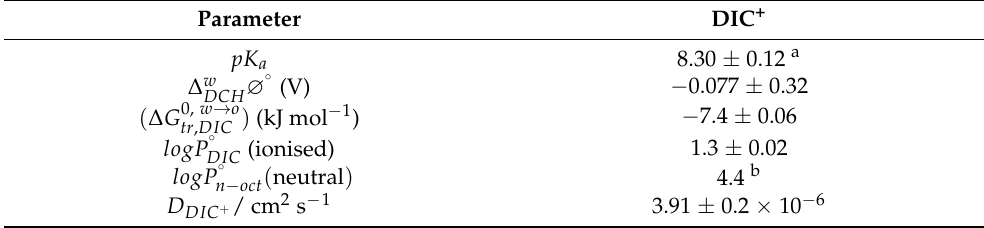
Table 1. The formal transfer potential, the standard Gibbs energy of transfer and the partition coefficient of ionized dibucaine drug in the water|1,6-DCH